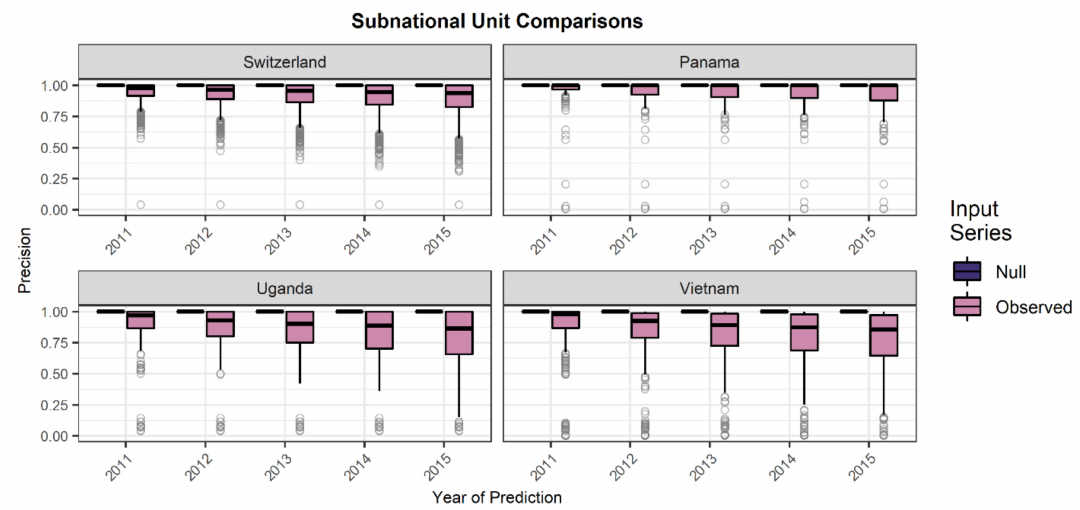
Figure 5. Boxplots of unit-level precision scores across countries and years in the projection period and divided by the input time series to the BSGMe framework. All precision values were calculated by comparing pixel-level agreement / disagreement with withheld annual ESA RS-derived extents. The median is indicated by the black line and outliers (outside of 1.5*the interquartile range) are given by grey